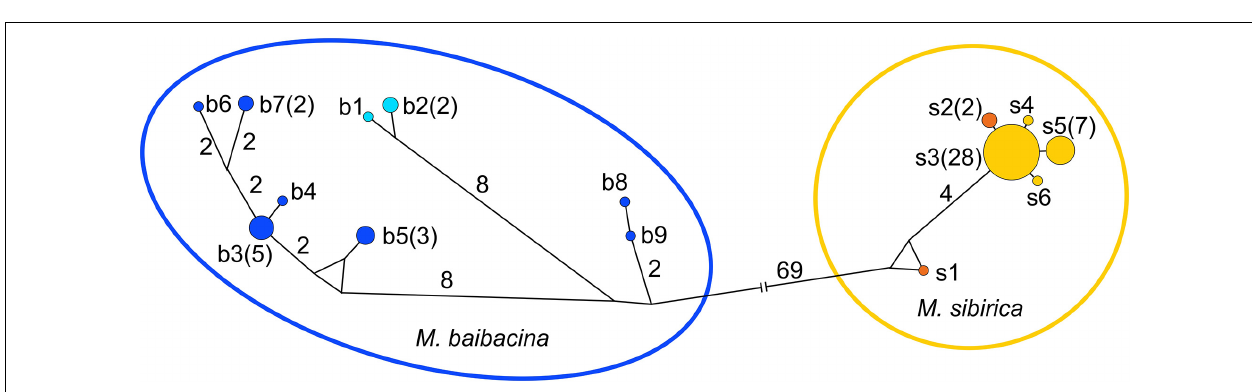
FIGURE 5 | The mtDNA control region haplotypes network. Haplotypes: light blue—“pure” M. baibacina ; orange—“pure” M. sibirica ; blue and yellow for M. baibacina and M. sibirica , respectively, from the mixed population. Haplotype designations as in Table 1 and Supplementary Figure 1 . Figures in brackets are the number of individuals. TABLE 4 | Ratios of CR genetic diversity of marmots in the Ulagchin-Gol valley population.